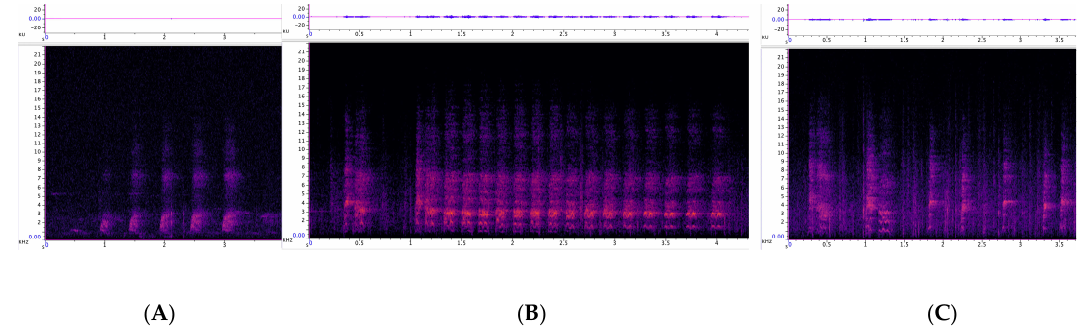
Figure 10. Paragalago calls from Mbololo Forest (upper images: waveform, lower images: spectrogram). ( A ) Screech is used as a contact call (Sound S19). ( B ) Chatter (Sound S20). ( C ) Chirrups and yaps (Sound S21). Mbololo Forest is very wet even during the dry season when it is not raining. This constant drizzle disturbs the recordings along with the almost constant chirping of